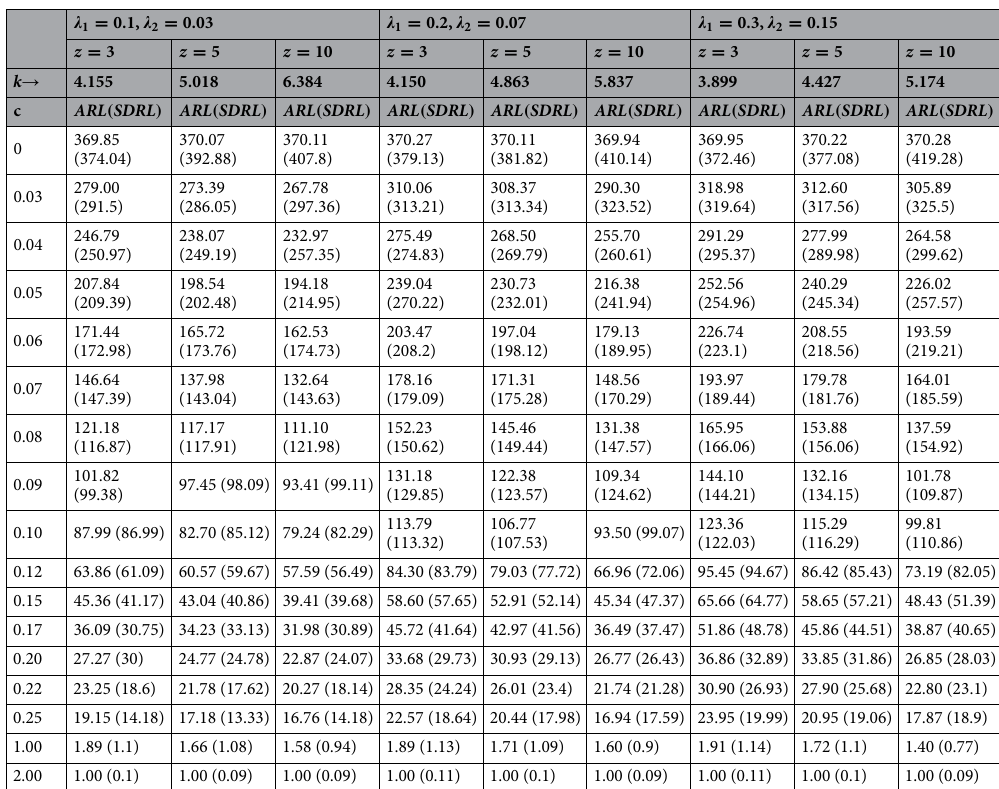
Table 1. ARLs of EEWMA-MA control chart when ARL 0 = 370, n = 5